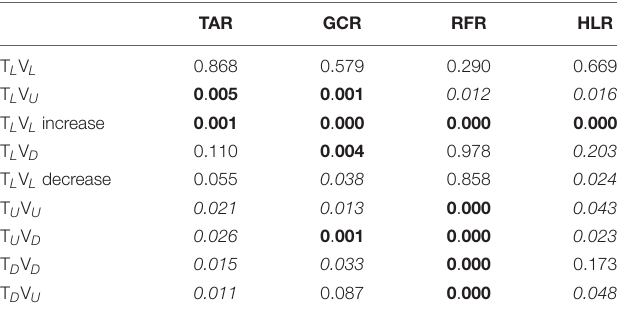
TABLE 1 | The grand averaged ( N = 12) p -value for summation magnitude of muscle activation between pre- and post-transition for all experimental conditions (see upper left corner in Figures 4 – 7 ).